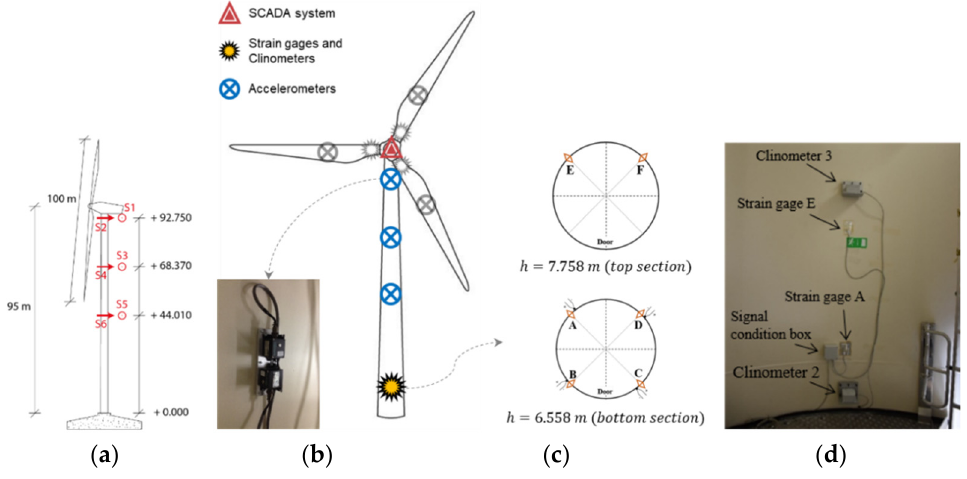
Figure 4. Tower monitoring systems: ( a ) sections instrumented with force balance accelerometers; ( b ) force balance sensors S1 and S2; ( c ) strain and rotation monitoring system; and ( d ) position of the strain gages ( ◊ ) and temperature sensors ( ) at the tower.